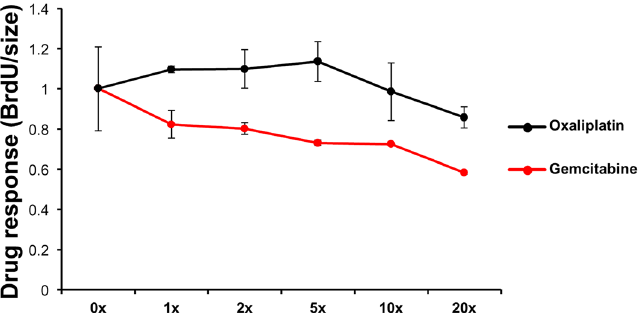
Figure 5. Drug response in the organoids derived from patient #2. Gemcitabine and oxaliplatin as indicated were applied to test the drug efficacy. The concentration ladders were based on the dose converted from clinical application (gemcitabine, 483 μM; oxaliplatin, 30 μM). The response to the treatment was determined by BrdU incorporation assay measuring DNA replication and normalized by the dimensions of the organoids (in diameter). Each data point was derived from two independent PDOs.